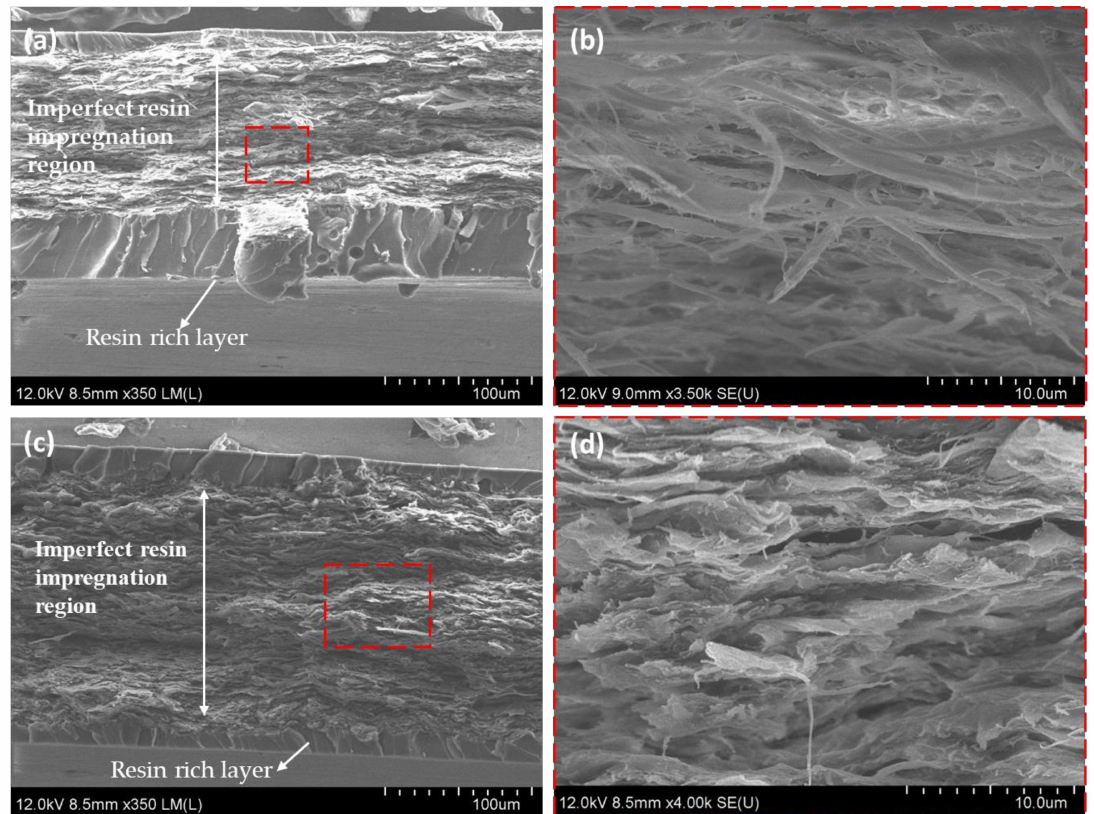
Figure 10. FE-SEM images of ( a ) 1 wt % water-dried CNF / epoxy composites; ( b ) high magnification of 1 wt % water-dried CNF / epoxy composites; ( c ) 1.5 wt % SCNF / epoxy composites; and ( d ) high magnification of 1.5 wt % SCNF / epoxy